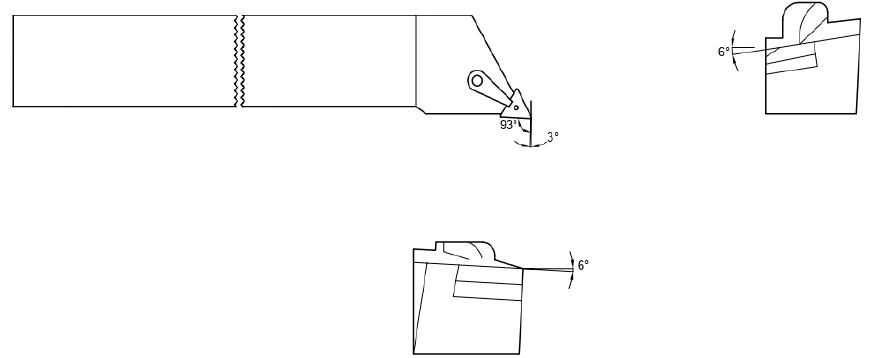
Figure 6. Cutting insert showing rake angle. Table 2. Geometry of cutting insert.